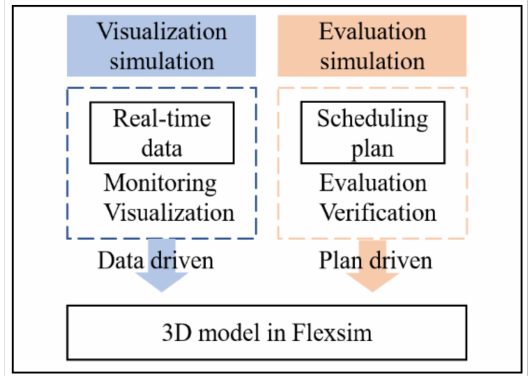
Figure 7. Simulation and Verification.